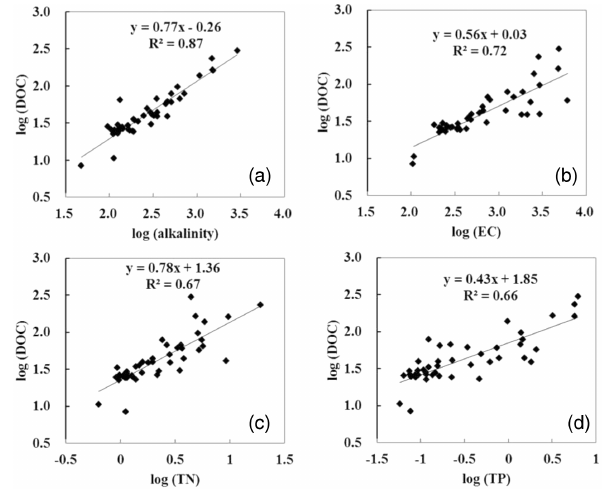
Figure 2. Correlation between DOC and alkalinity, EC, TN, and TP in Hulun Buir plateau water.